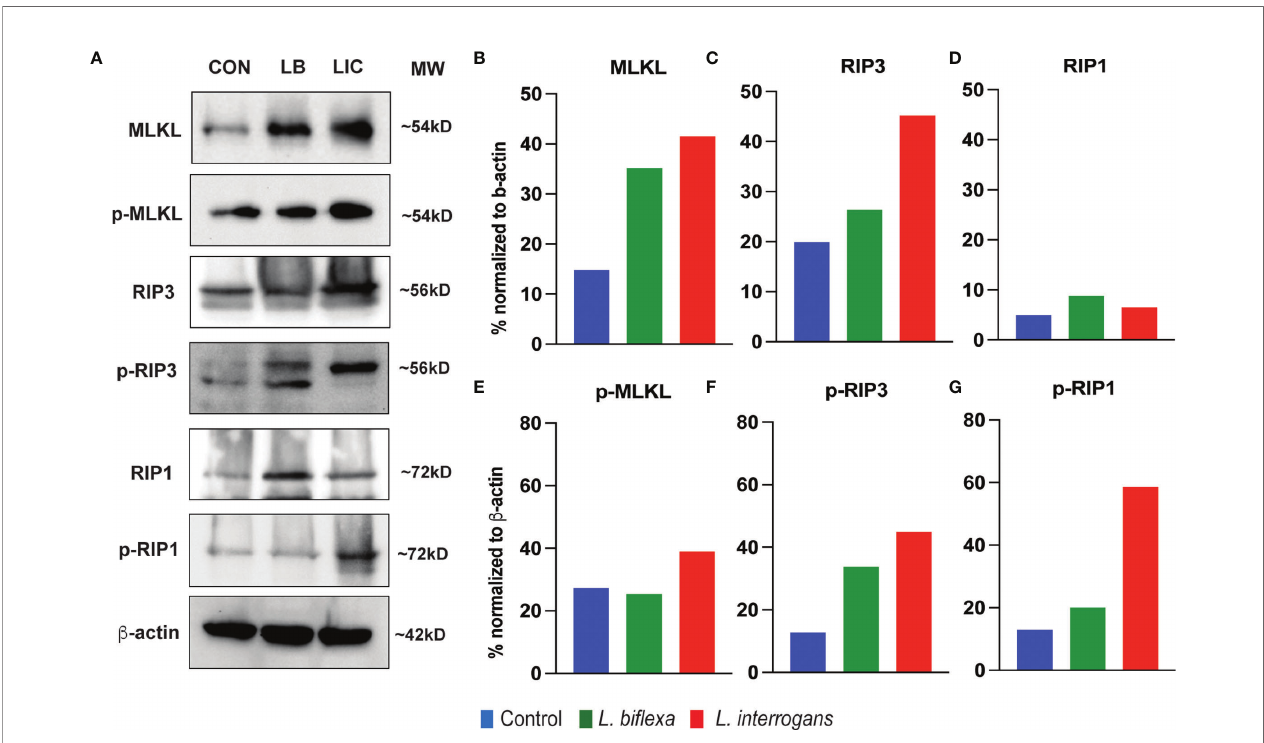
FIGURE 6 | Protein expression of key biomarkers of necroptosis at 72h post infection. (A) represents the immunoblots of protein lysate (whole spleen cells) from uninfected Control (CON), nonpathogenic L. bi fl exa (LB) and pathogenic L. interrogans (LIC) infected groups. (B – G) represents the densitometric histograms